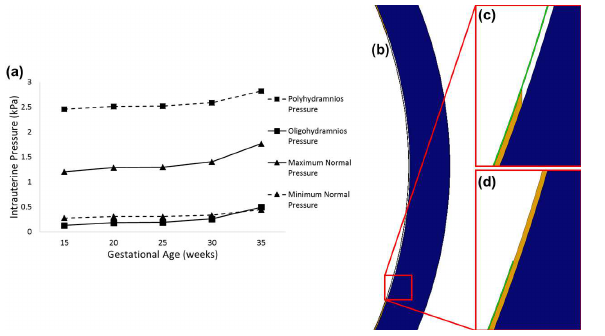
Fig 2. (a) Graph of previouslyreported or calculatedchangesin maximum and minimum intrauterine pressure[37], and intrauterine pressureduringpolyhydramnios and oligohydramnioscalculatedfrom [45], over gestation. Diagramshowinga partitioned membranemodel with (b, c) a section of chorion removed, and (d) a section of amnion